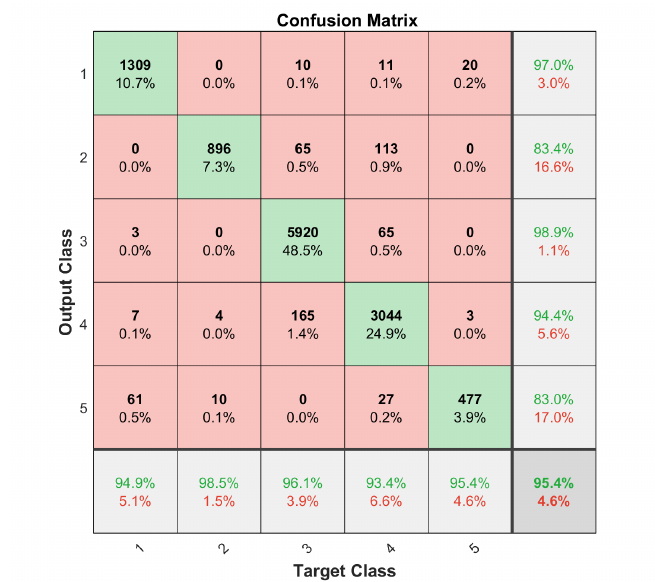
Figure 9. Classification accuracy of balanced training of 35 selected miRNAs by NCA.